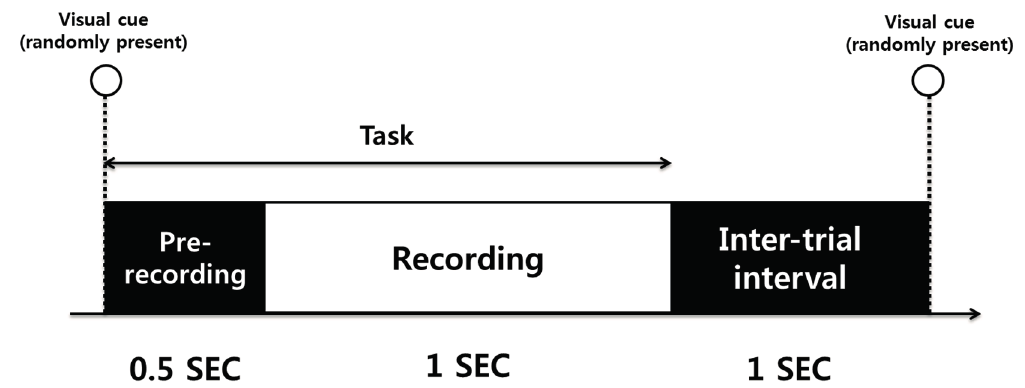
Figure 4. Experimental procedure. Visual cues (0 cm, 4 cm, 8 cm and 12 cm) were randomly presented during the tasks (1.5 s). Pre-recording (0.5 s) and inter-trial intervals (1 s) were also